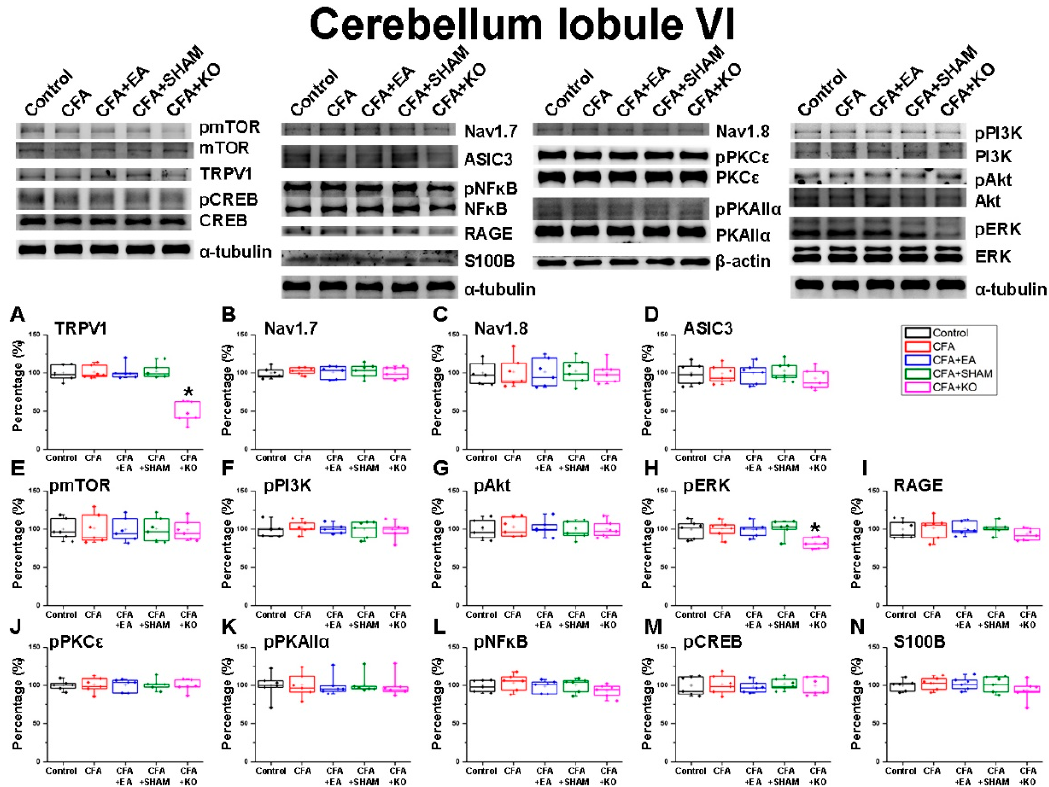
Figure 3. The expression levels of pain receptors and involved molecules in the cerebellum lobule VI. The immunoblotting images contain five lanes of protein in the following order: control, CFA, CFA + EA, CFA + SHAM, and CFA + KO groups. There are no significant difference for ( B ) Nav1.7, ( C ) Nav1.8, ( D ) ASIC3, ( E ) pmTOR, ( F ) pPI3K, ( G ) pAkt, ( I ) RAGE, ( J ) pPKC ε , ( K ) pPKAII α , ( L ) pNF κ B, ( M ) pCREB, and ( N ) S100B protein level among the five groups of subjects ( p > 0.05). However, the protein density of ( A ) TRPV1 and ( H ) pERK reveal significant decreases in the CFA + KO group compared to the other four wild-type groups (* p < 0.05).